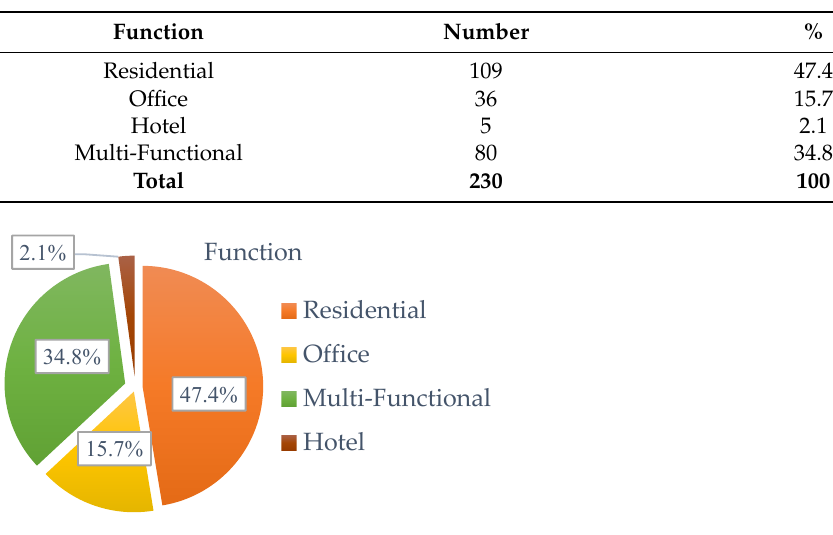
Figure 2. Analysis of selected tall buildings by function.